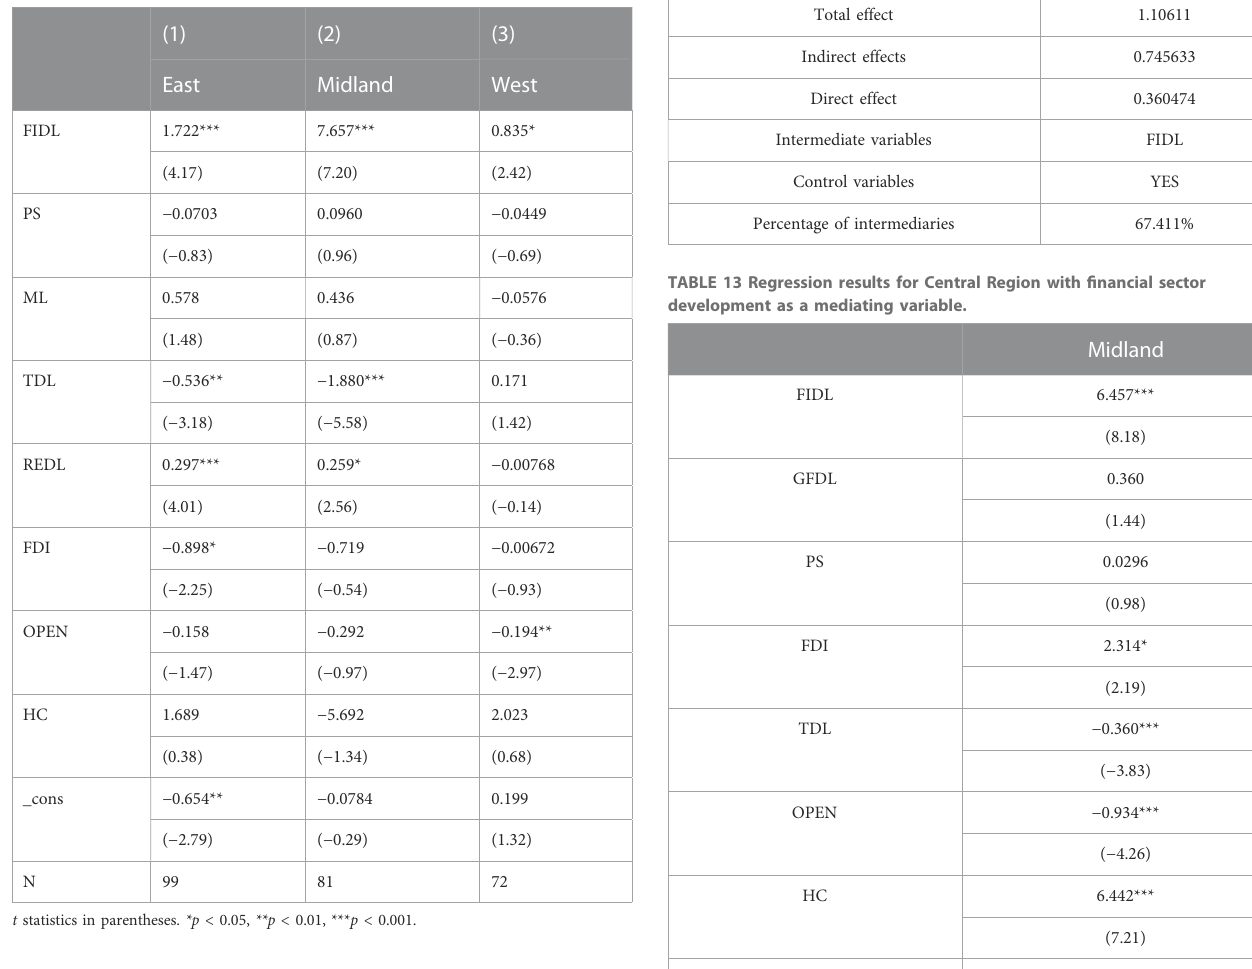
TABLE 10 Regression results based on the inclusion of control variables for Hypothesis 2 sub-region.